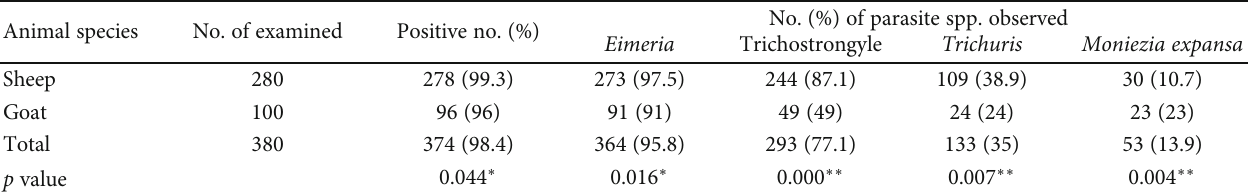
Table 2: Occurrence of gastrointestinal parasites in sheep and goats. Animal